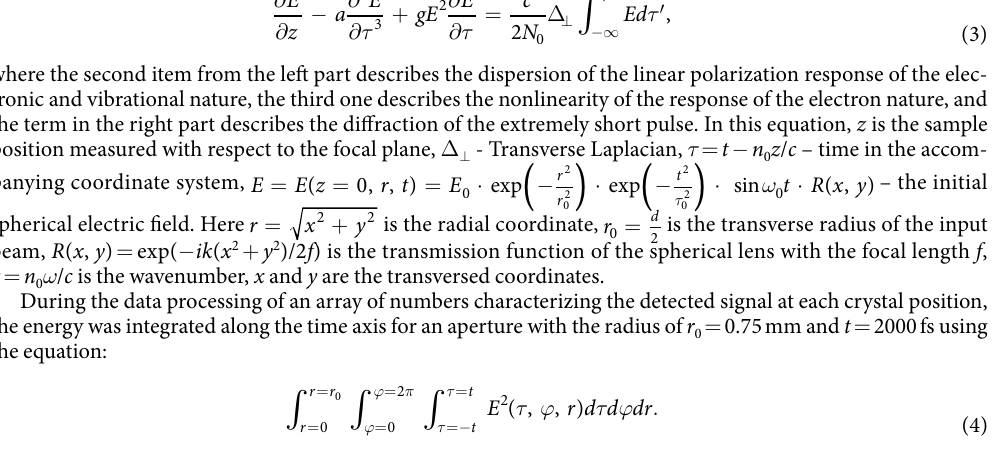
caustic I 0 = 3.1 ⋅ 10 8 W/cm 2 . The dispersion parameters are specified in 43 and are approximated by the formula